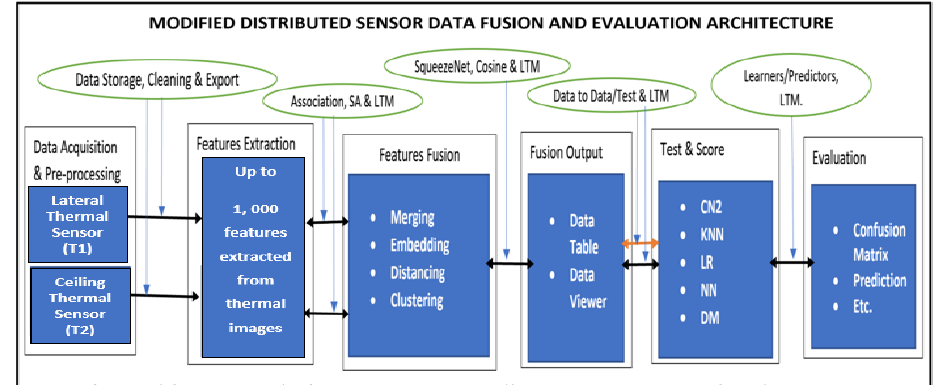
Figure 8. Modified distributed sensor data fusion architecture for lateral (T1) and ceiling (T2) thermal sensors. In Figure 8 , data acquisition and preprocessing are performed by individual thermal sensors (T1 and T2). Up to 1000 features are extracted from the thermal (grayscale and binary) images. Thermal blobs gleaned from the ITA sensors are stored in a predetermined folder with timestamps to enable a time-based fusion of the data. During sensor fusion, data from T1 and T2 were imported into the data merging system. The system then created an imaginary table for the two sets of data before carrying out a matching row appending. Whilst file-import enables the reading of tabular data and their instances from an Excel spreadsheet or a text document, the image-import